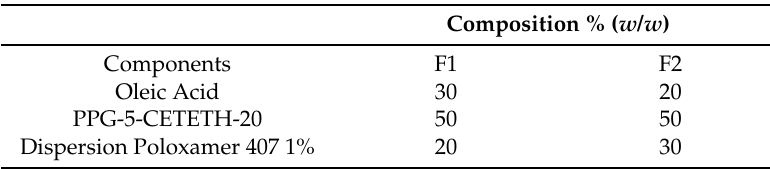
Table 4. Formulation